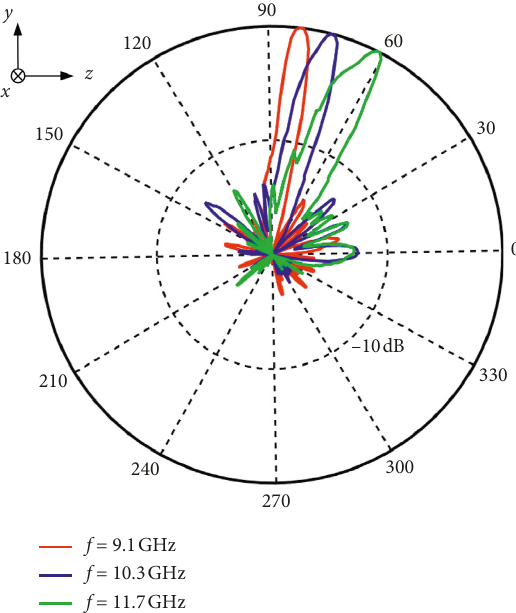
Figure 7: The measured radiation pattern of the proposed periodic antenna in the backward direction.